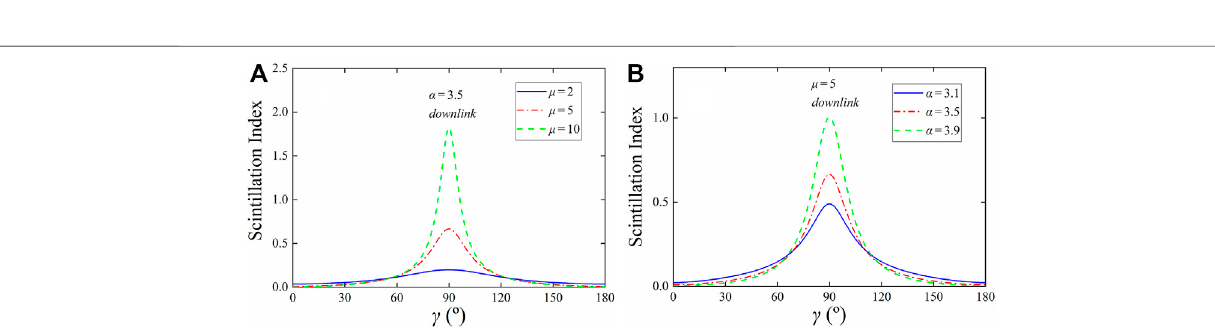
FIGURE 2 | Anisotropy of the turbulence cell for the vertical link in the presence of the anisotropic tilt angle γ .